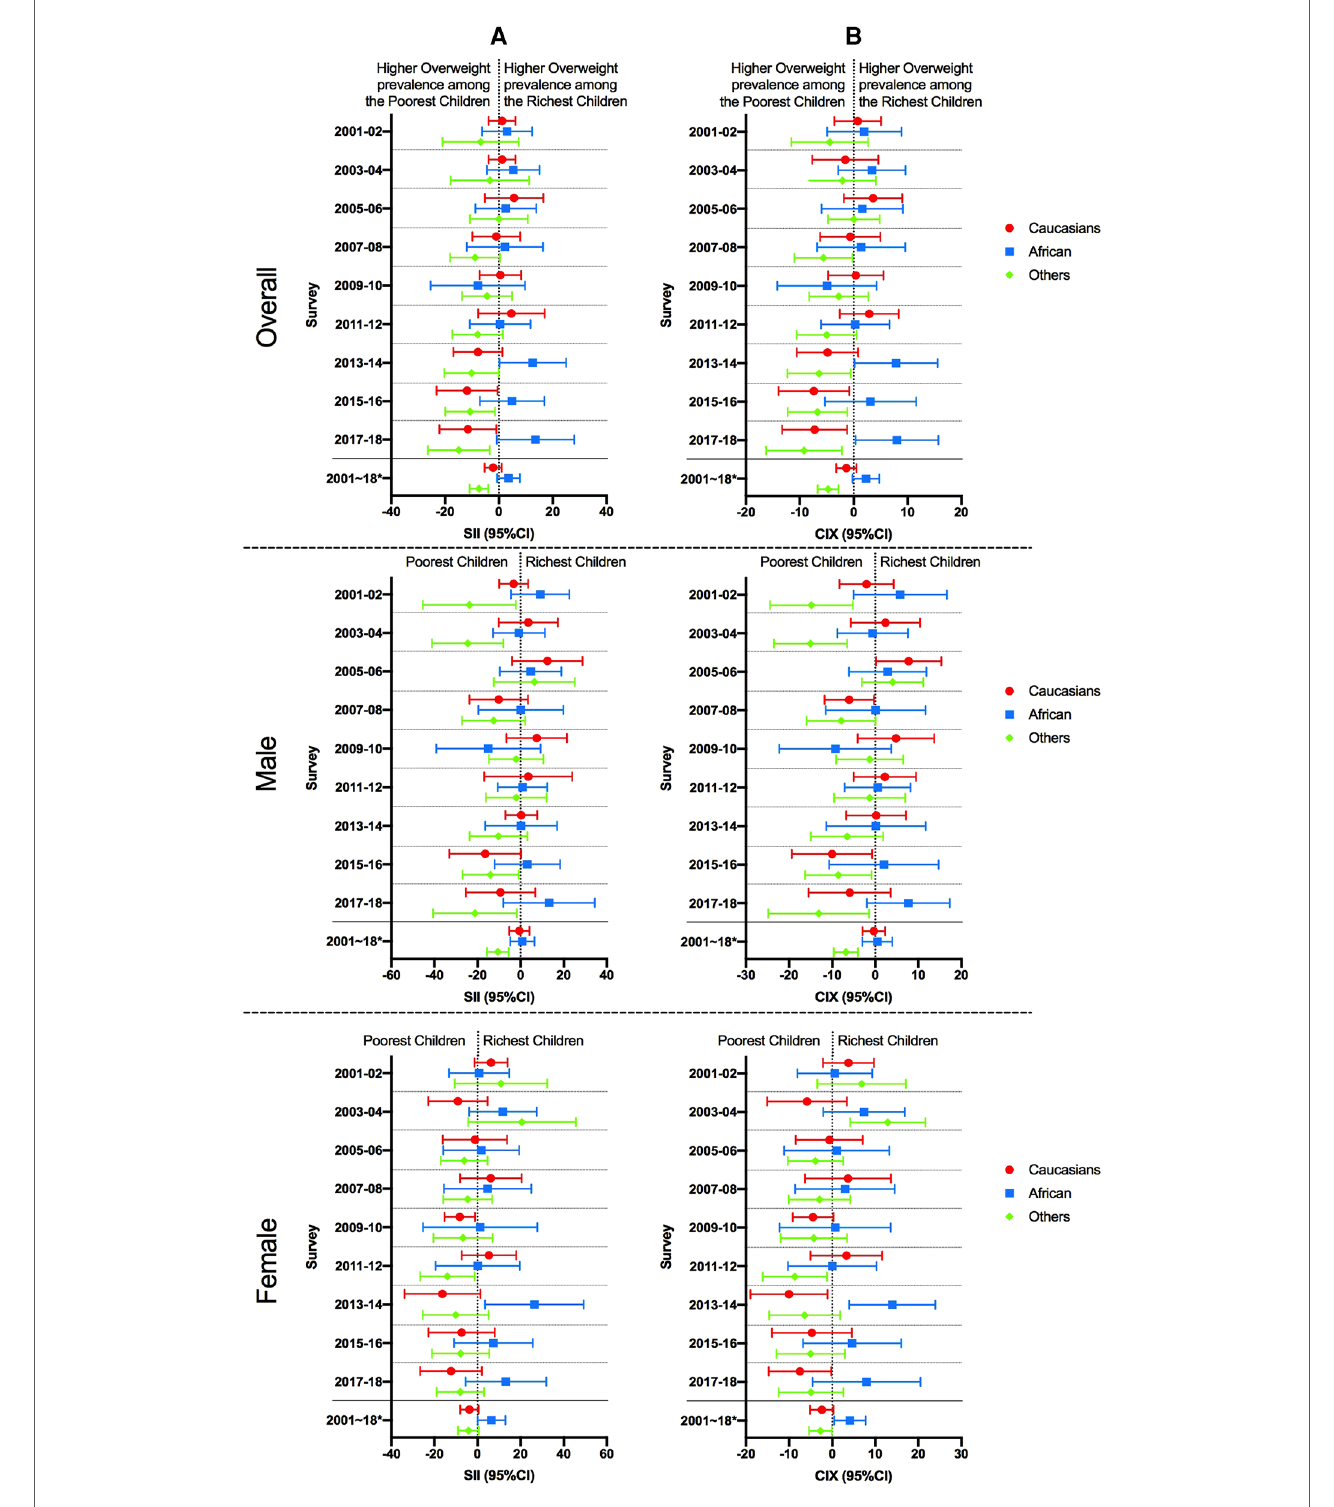
FIGURE 3 Absolute and relative wealth inequality of overweight/obesity prevalence among children by sex for each year of survey and pooled data. CIX: concentration Index, SII: Slope Index of Inequality. Caucasian: Caucasian, African: African American, Others: other ethnicities. CI: con fi dence interval.*: pooled data. ( A ) Relative inequality, ( B ) Absolute